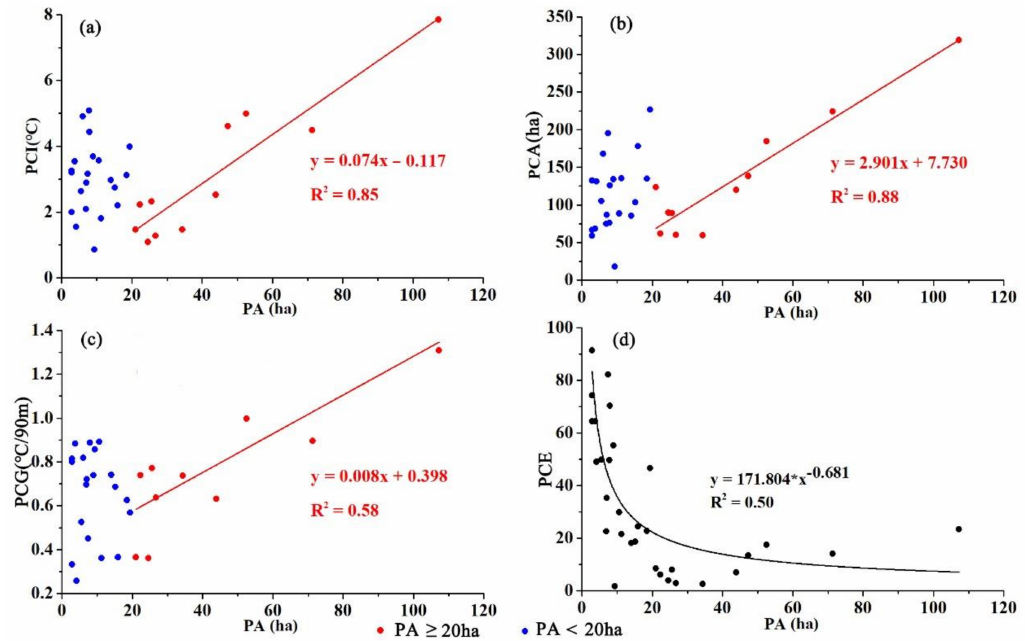
Figure 8. Linear regression models of the PA and ( a ) PCI, ( b ) PCA, ( c ) PCG, and ( d ) PCE.